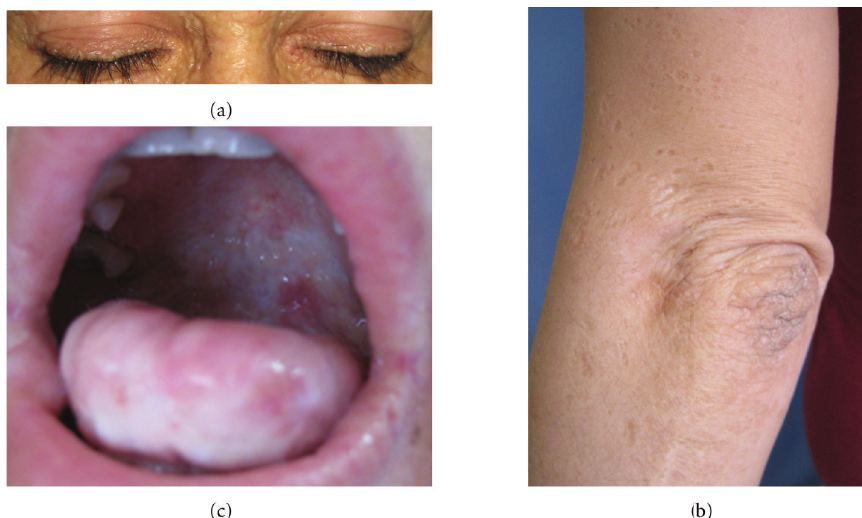
Figure 2: (a) Classic beaded eyelid papules-indurated papules at the base of eyelashes. (b) Pock-like scars on the left arm and hyperkeratotic, verrucous plaque on the left elbow. (c) Yellow infiltrated plaques on hard palate and under the tongue.